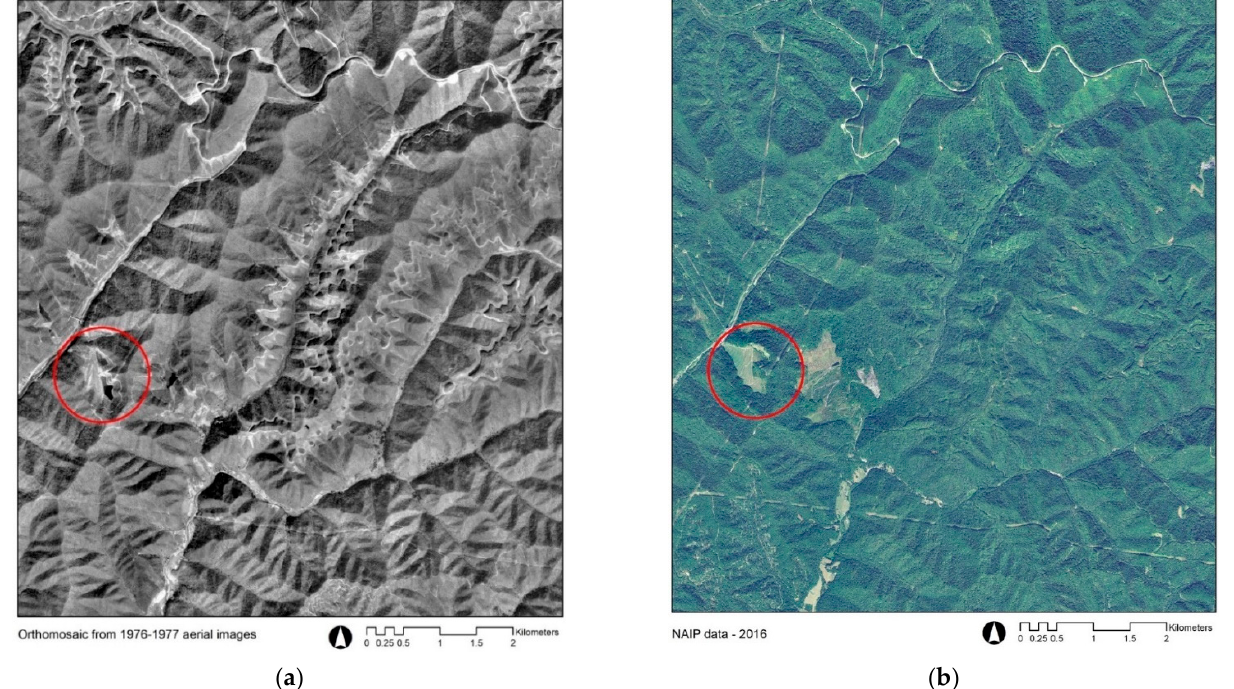
Figure 2. Comparison of aerial views of the same area in 1976–1977 and 2016. After 40 years of vegetation growth, strip mining effects can be barely distinguished from the aerial images. Images are representative of the scale of surface mining operations that occurred in the area before the 1977. The site number 253 (Figure 1b) is highlighted in the red circle in both images. ( a ) Map derived from the orthomosaic used for the land cover classification of 1976. ( b ) Map is based on the USDA National Agriculture Imagery Program (NAIP) 2016 dataset.